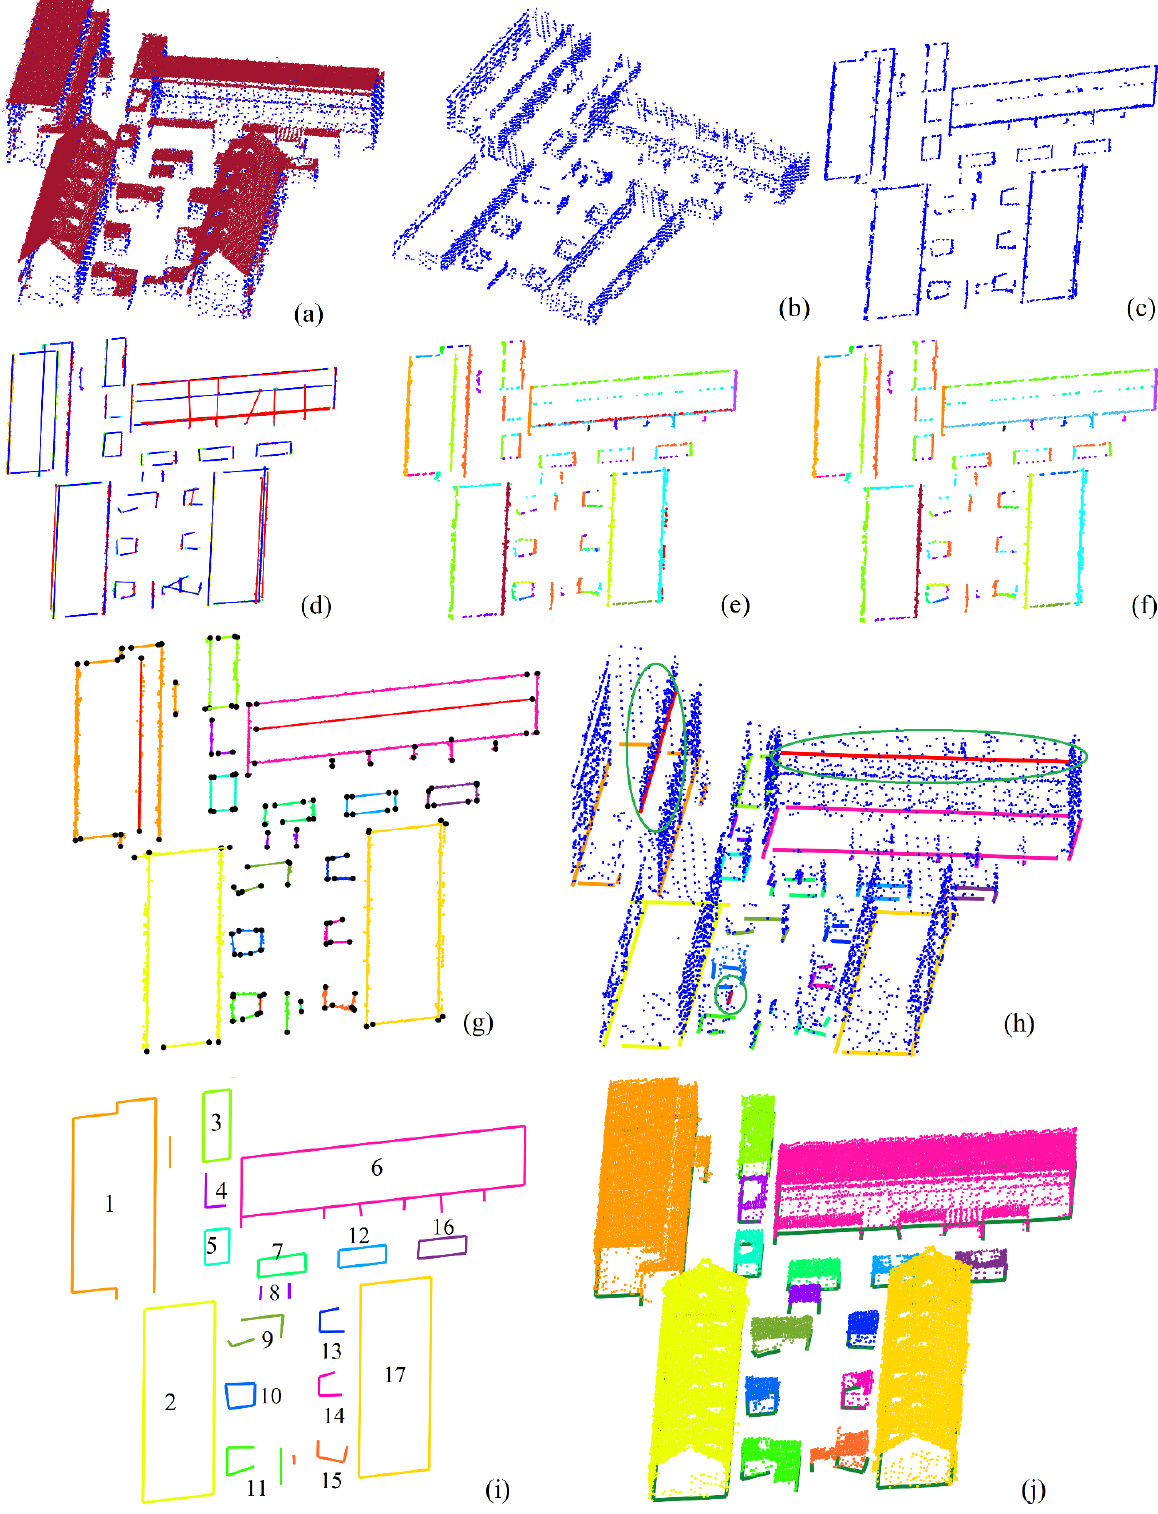
Figure 6. Building footprints extraction of AHN data set: (a) classification of vertical (blue) and non-vertical (maroon) surfaces, (b) 3D vertical surfaces (facades) below the roofs, (c) 2D ( x , y ) points for the vertical surfaces, (d) extracted lines using MSAC for the points in plot (c), (e) spatial segmentation for the 2D facades points in plot (d), (f) elimination of redundant/false (red) lines in (e); using 𝐴 𝑡 = 5 0 , and n PT=10, (g) LTS regression lines for the points in plot (f); black dots are the end points of the lines, (h) footprint- lines for the buildings in 3D, red lines within the three green ellipses are from the hanging walls that have no ground connection, (i) final footprint-lines for the buildings, and (j) footprint (green)-lines aligned with the 3D buildings in plot